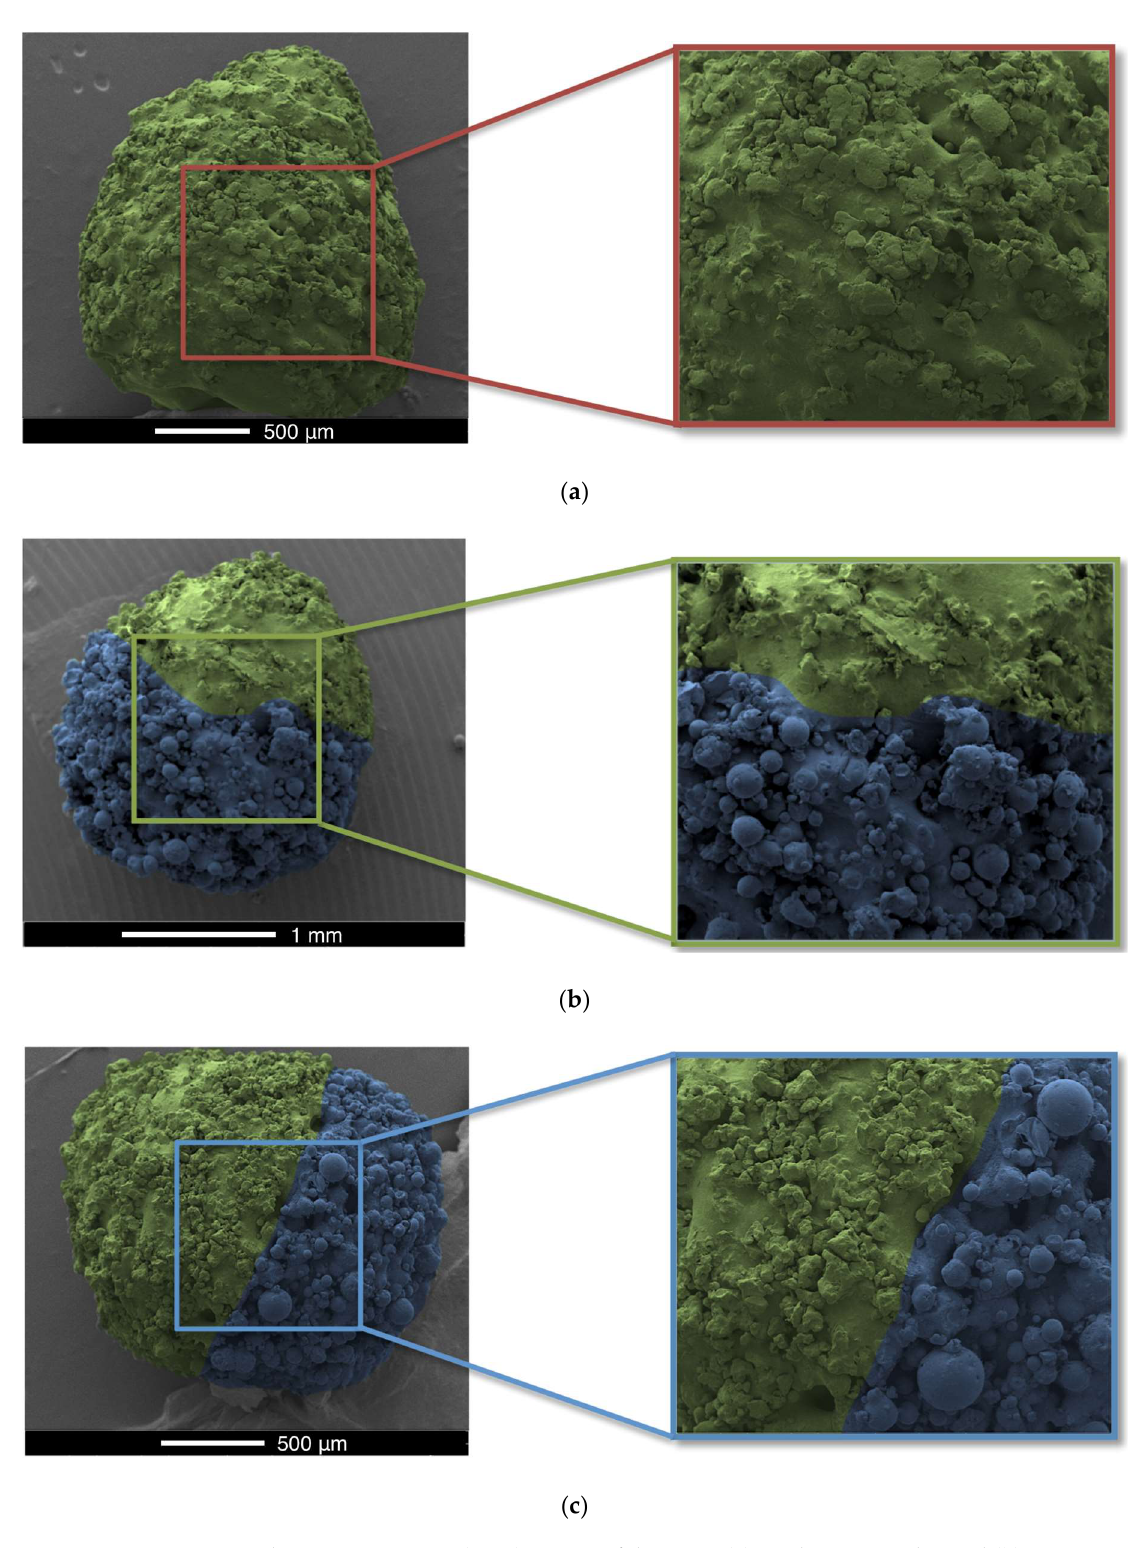
Figure 6. Scanning electron microscopy ( SEM) images of the 2 mm ( a ) single miniprintlet, and ( b ) Con A and ( c ) Con B of the dual miniprintlets. The yellow regions represent the EC regions, whereas the blue regions represent the KIR regions.